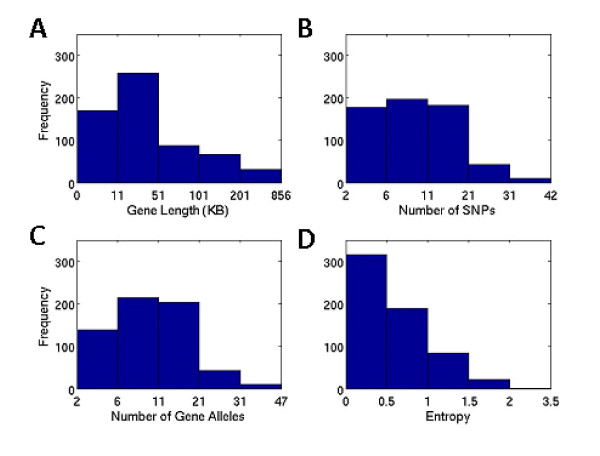
Histograms of the characteristics of genes (N = 611) selected in this project. Note that the interval length of each group is not evenly distributed.